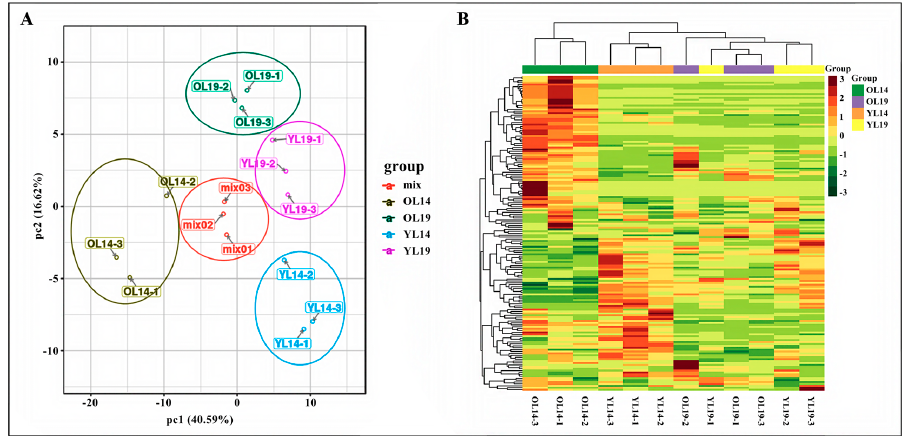
Figure 2. Differential flavonoid metabolite analysis on the basis of principal component (PCA) and clustering heat map. ( A ) PCA score map. ( B ) Clustering heat map of metabolites. Based on OPLS-DA results, the differentially accumulated flavonoids (DAFs) with significant differences were counted for the four groups (YL14_vs_OL14, OL14_vs_OL19, YL19_vs_OL19, YL14_vs_YL19) in the range of VIP (The Variable Importance in the Projection) ≥ 1, with Log2FC (multiple of difference for log2 treatment) ≥ 2 and Log2FC ≤ 0.5. In YL14_vs_OL14, there were 10 DAFs downregulated (It meant that there were 10 kinds of DAFs that were lower in OL14, compared to YL14) and 37 DAFs upregulated; YL19_vs_OL19 had 15 DAFs downregulated and 18 DAFs upregulated; OL14_vs_OL19 had 44 DAFs downregulated and 5 DAFs upregulated; YL14_vs_YL19 had 33 DAFs downregulated and 6 DAFs upregulated. Next, we checked composition of DAFs with significant differences within each of the comparing groups and the results were visualized using volcano plot. This reveals that the distribution of downregulated metabolites in OL14_vs_OL19 of yellow color difference group was symmetrical with that of upregulated metabolites in YL14_vs_OL14 (Figure 3A,B). While such pattern has not been observed in the no yellow color difference group (Figure 3D,E). Further analysis showed that there were 35 kinds of the same DAFs in the yellow color difference group YL14_vs_OL14 and OL14_vs_OL19, accounting for 57.4% (Figure 3C), while there were only 7 kinds of the same DAFs in the no yellow color difference groupYL14_vs_YL19 and YL19_vs_OL19, accounting for 10.8% (Figure 3F). It was found that 30 kinds of DAFs in the yellow color difference group were upregulated in OL14 and downregulated in OL19 and YL14 (Table 1). When the contents of each of the 30 DAFs were added together, the total content of flavonoid metabolites in OL14 was 95 times that of OL19 and 35 times that of YL14. These DAFs are divided into seven categories, including flavones, isoflavones, flavonols, flavanones, flavone C-glycosides, anthocyanins, catechin derivatives. In this study, the flavanones with high content in OL14 were naringenin O-malonylhexoside and naringenin. The isoflavones with high content in OL14 were 6-Hydroxydaidzein, glycitein and calycosin. Four substances in flavone C-glycosides (apigenin C-glucoside, isovitexin, naringenin C-hexoside, C-hexosyl-apigenin O-caffeoylhexoside) were detected in young cucumber YL14 and old cucumber OL14, but these four substances accumulated significantly in old cucumber OL14. Two flavonols (kaempferide and dihydrokaempferol) and two flavones (acacetin O-acetyl hexoside and sakuranetin) were accumulated only in OL14. The callistephin chloride in anthocyanins and the epicatechin gallate in catechin derivatives were detected in OL14. For most of these flavonoid metabolites, they showed existence/nonexistence patterns in OL14, OL19 and YL14, indicating that they are the key components leading to cucumber peels to turn